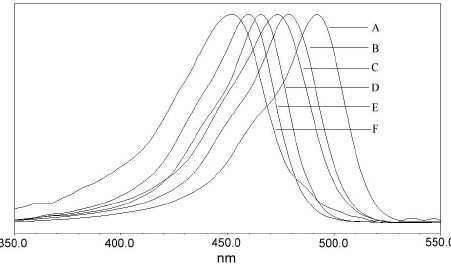
Figure 10. Absorption spectra of the N -de-methylated intermediates formed during the photocatalytic degradation process of the